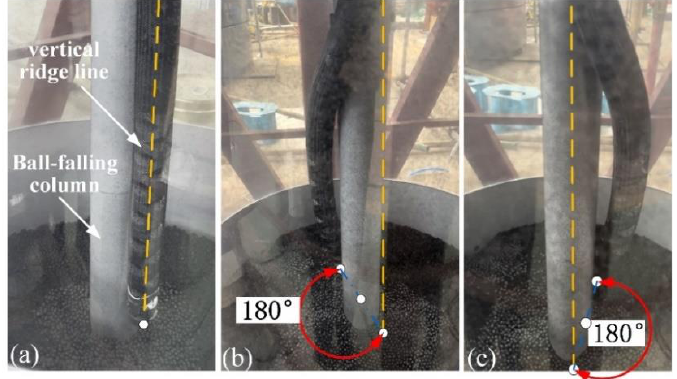
Figure 14. Test of the continuum robot around the column: ( a ) initial state; ( b ) 180° left around the column; ( c ) 180° right around the column.